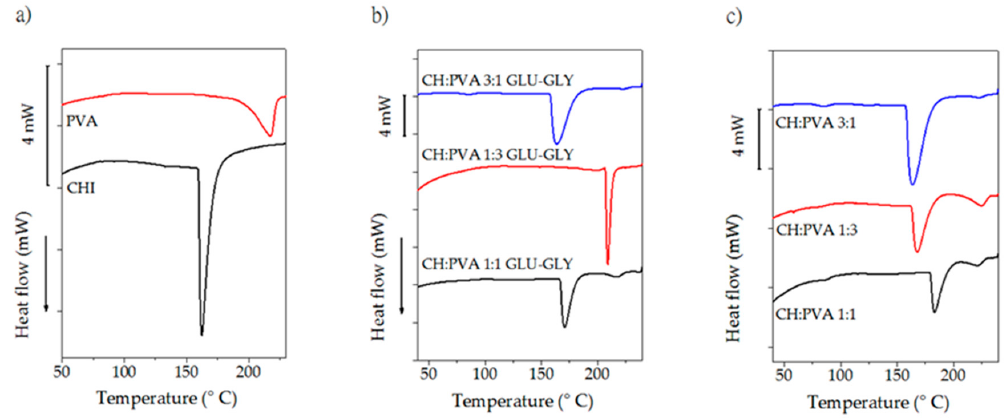
Figure 4. Thermograms for the studied materials. ( a ) Pure polymers; ( b ) CPS; ( c ) nCPS. Table 3. Thermal characteristics of the studied samples.